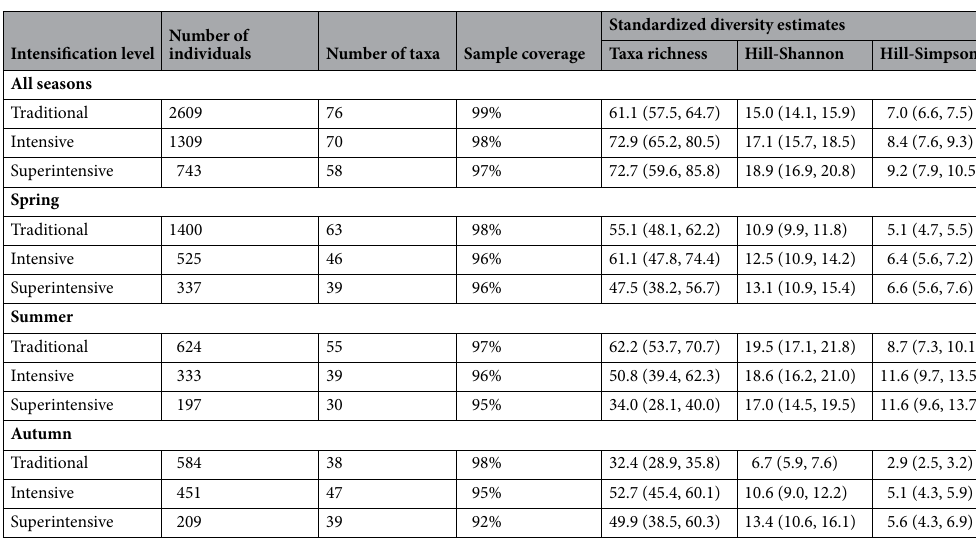
Table 3. Estimates of Hill diversity (± 95% confidence intervals) for each orchard intensification level, per season and for all seasons combined. The number of individuals and taxa collected are presented, as well as sample coverage for each intensification level. Diversity estimates are standardized at a coverage of 98.5% for all seasons combined, 97.9% for spring, 97.4% for summer and 96.8% for